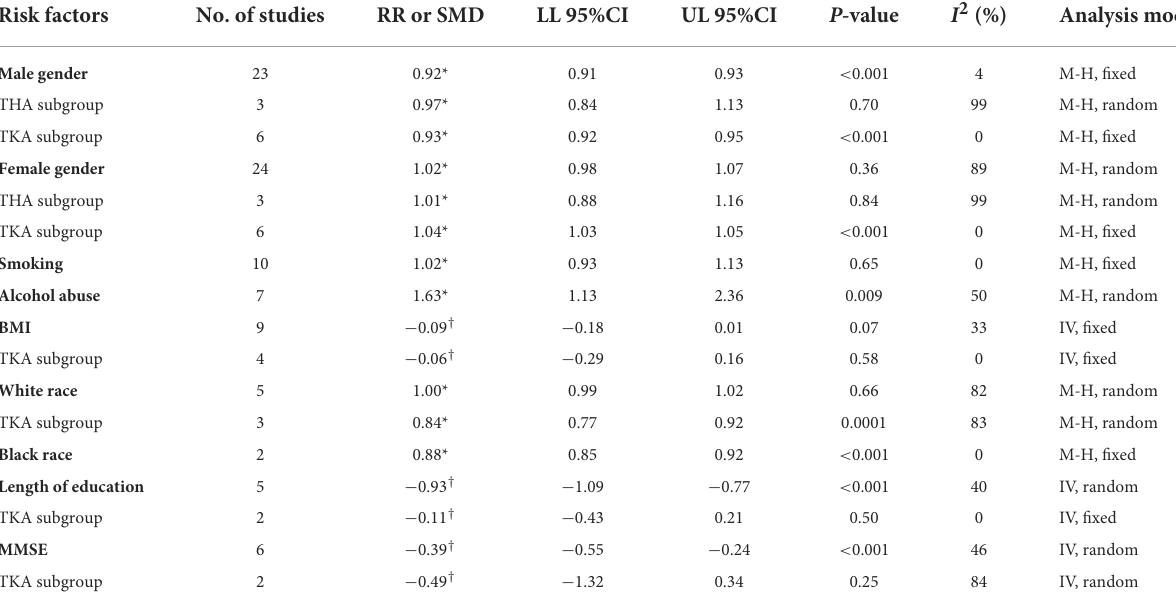
TKA subgroup THA, total hip arthroplasty; TKA, total knee arthroplasty; BMI, body mass index; MMSE, Mini-mental State Examination; RR, Relative Risk; SMD, standardized mean differences; LL, lowerlimit;UL,upperlimit;M-H,MantelHaenszeltest;IV,inversevariance. *RR. † SMD. TheforestmapofallriskfactorsisshowninSupplementarymaterial2.